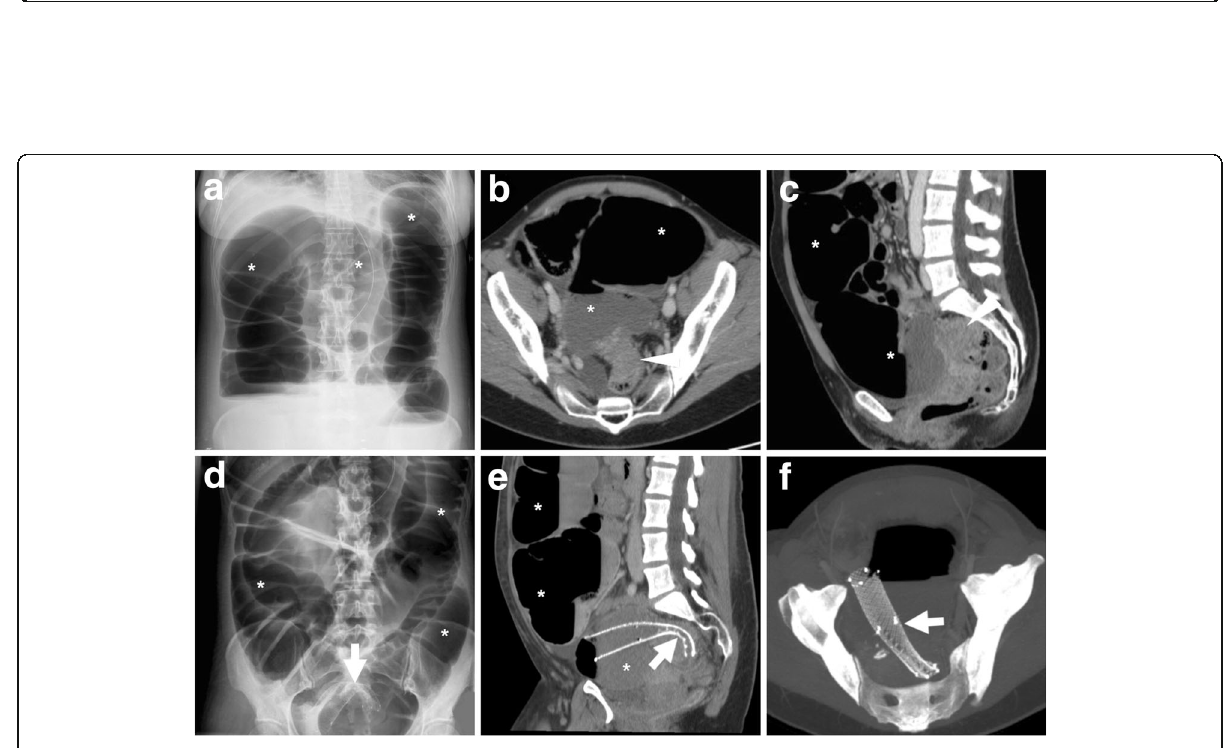
Fig. 15 Failed relief of LBO from SEMS treatment of deep infiltrating endometriosis. Initial upright radiograph ( a ) showed severe colonic dilatation (*) with prominent air-fluid levels consistent with high-grade obstruction. Axial ( b ) and sagittal ( c ) CT images confirmed LBO (*) above a segmental mural thickening (arrowheads) at the rectosigmoid junction, which corresponded at pathology to endometriosis. After SEMS (thick arrows) positioning at an impassable extrinsic stricture 15 cm above the anal verge, radiographic follow-up ( d ) and CT ( e , f ) showed persistent LBO (*). Sagittal ( e ) and MIP ( f ) CT images showed incomplete expansion of the SEMS (thick arrows). Immediate laparotomy with rectosigmoid resection and temporary stoma was required